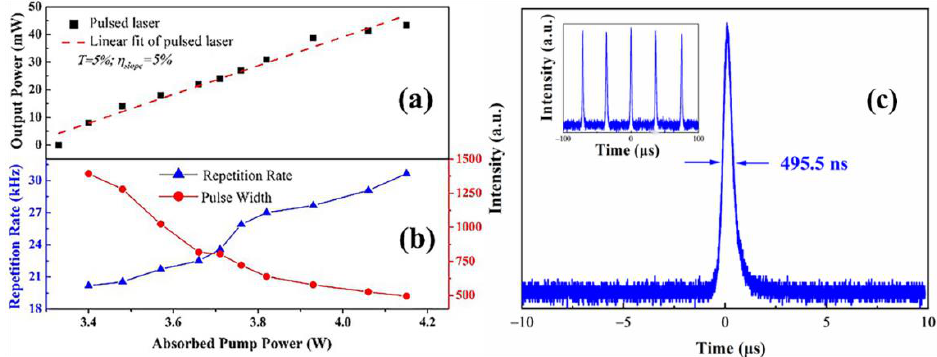
Figure 9. ( a ) Pump power versus average pulsed output power, ( b ) pump power as a function of repetition frequency and pulse width, respectively, and ( c ) single pulse. Inset: pulsed train